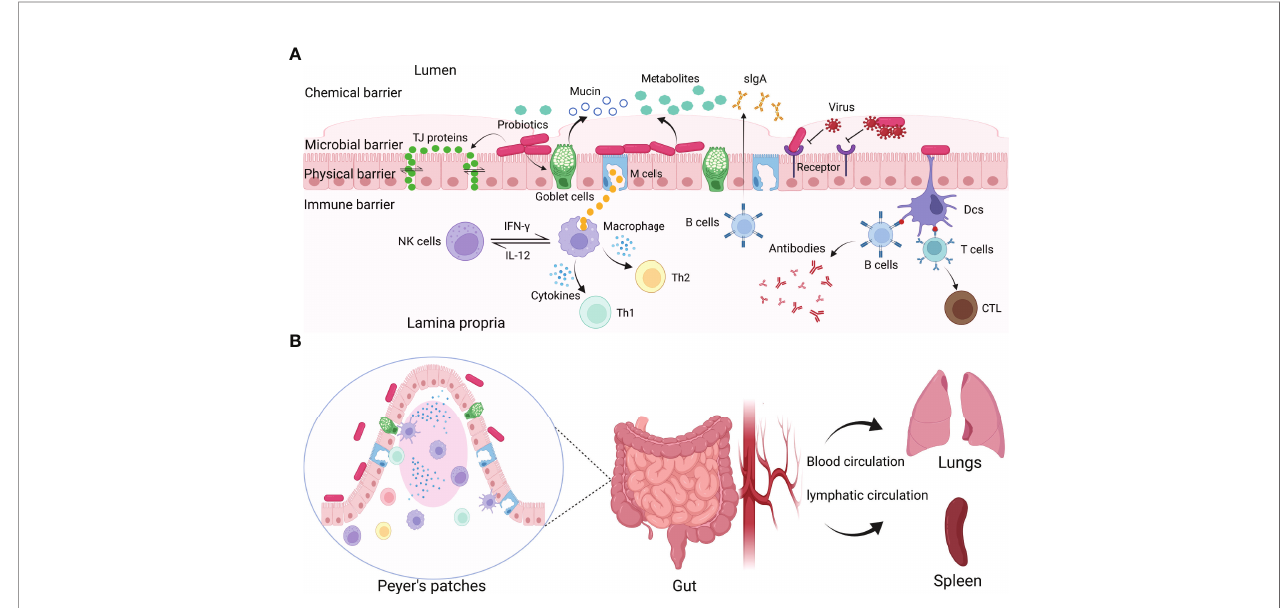
FIGURE 1 | The interactions between probiotics and viruses. (A) Probiotics exert protective effects on viral infections by constituting or modulating chemical, microbial, physical, and immune barriers. Probiotics can produce antiviral metabolites, block virus invasion by binding with viruses or competing for the entry receptors, regulating the tight junctions of IECs, and modulating mucosal immune responses. (B) Probiotics modulate systemic immune